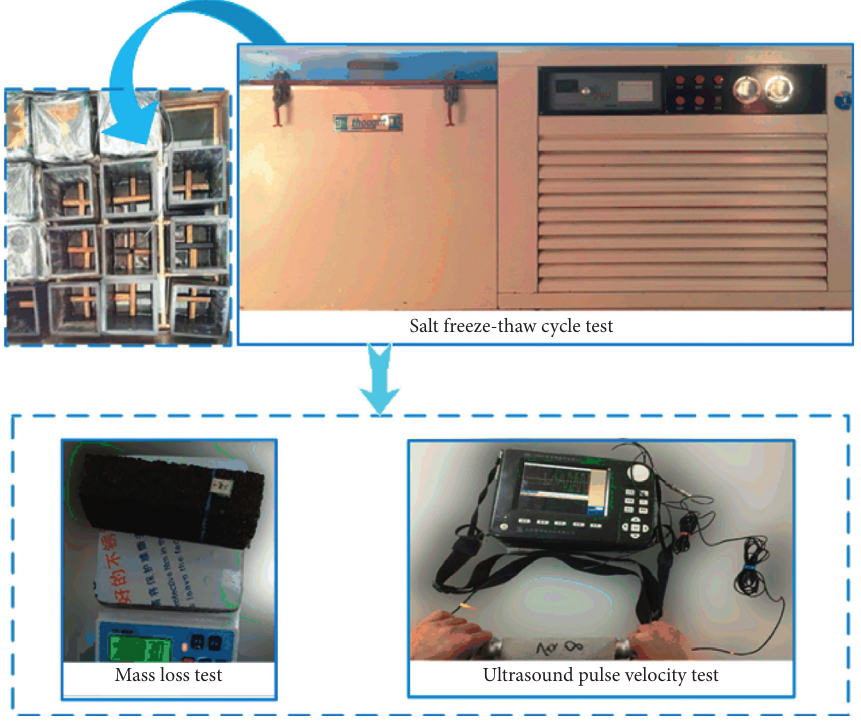
Figure 4: Salt freeze-thaw cycle test of cement